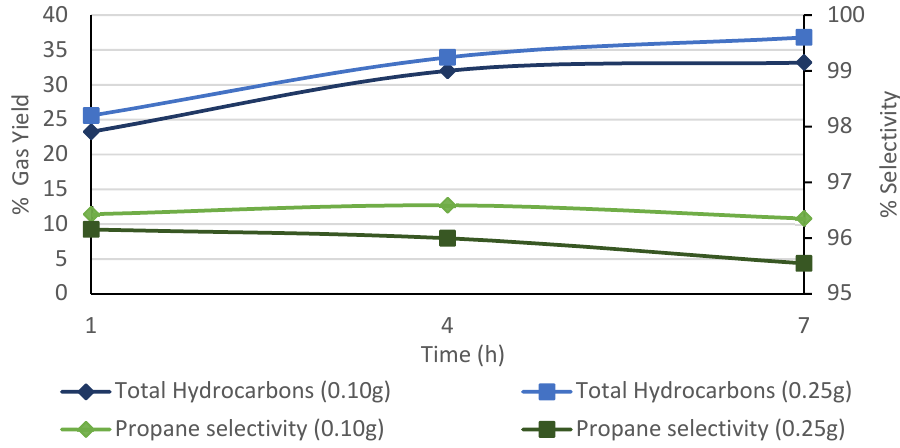
Figure 7. Effect of residence times (h) with 0.10 g and 0.25 g of bulk Pt/C with 1.0 g (1.14 M) butyric acid at 300 °C.